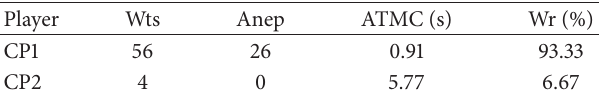
Figure 6: Comparison of the winning rates of the computer player.